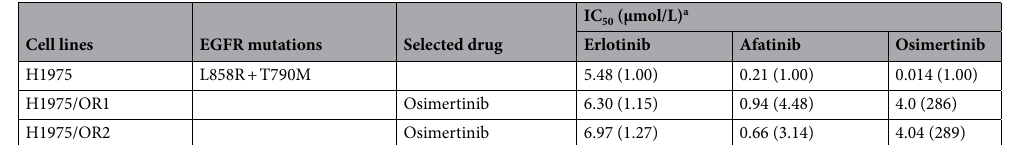
Table 1. Cytotoxicity of erlotinib, afatinib or osimertinib in H1975 and osimertinib-resistant cell lines. a The relative resistance, defined as the IC